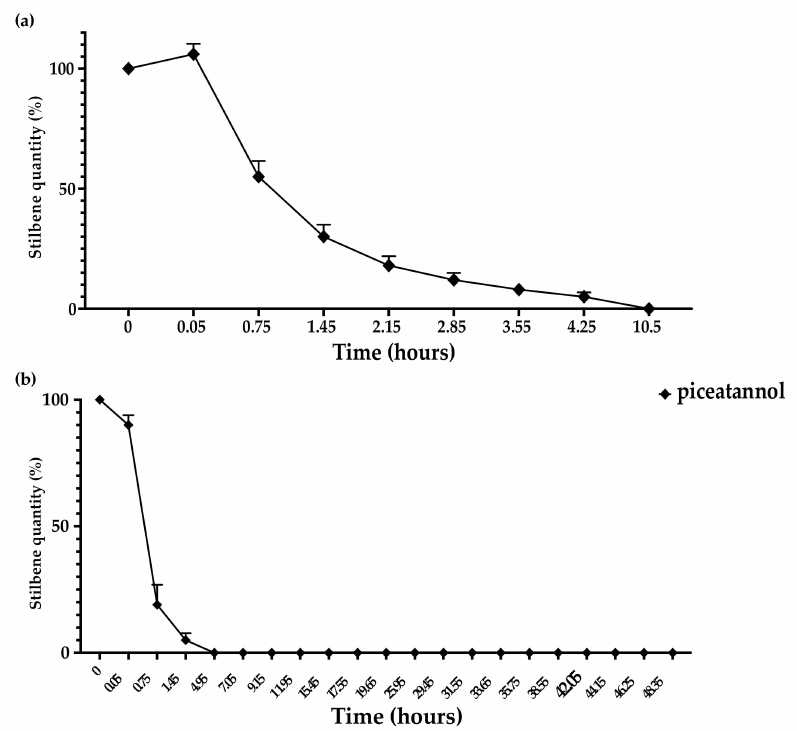
Figure 10. Kinetics of trans -piceatannol (5 µ g/mL) metabolization in sodium acetate buffer by total extracellular protein extract isolated from ( a ) D. seriata (200 µ g/mL) and ( b ) N. parvum (1 mg/mL). Evolution of trans -piceatannol contents is represented by diamond dots. Error bars represent standard error of the mean (SEM). Mean and SEM were calculated over three biological replicates, each comprising two technical replicates ( n =